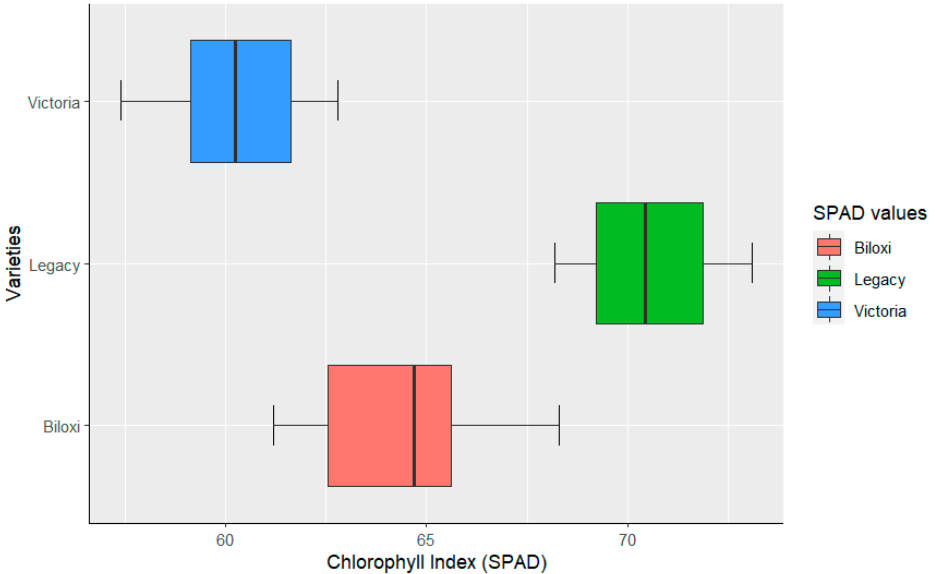
Figure 1. Box-plot of the Chlorophyll index (SPAD) in Biloxi, Legacy and Victoria variety Blueberry plants grown under Colombian high tropic conditions.